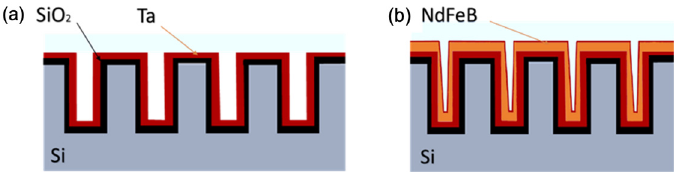
Figure 10. Schematics of microfabrication process to produce grids of micromagnetic poles with NdFeB. ( a ) Silicon wafer is micropatterned using lithography and etching and coated with SiO 2 layer 100 nm thick, and then 100 nm thick Ta layer is sputtered to serve as a reaction barrier between SiO 2 and NdFeB; ( b ) 30 µ m thick NdFeB layer is sputtered and coated with 500 nm Ta layer.